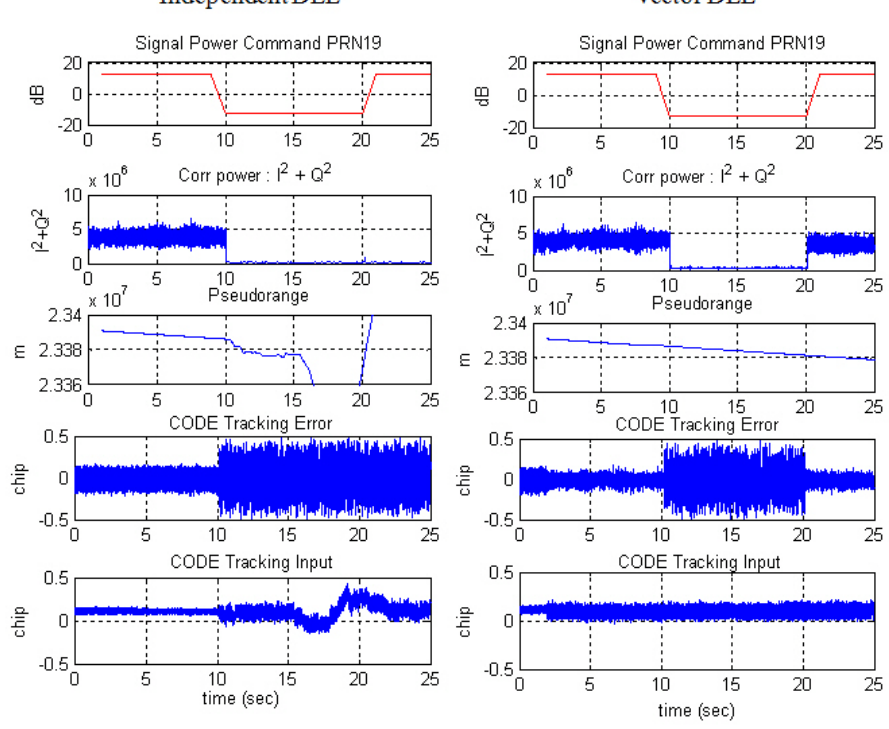
Figure 11. Code tracking result of PRN 19: Independent DLL (left) and Vector DLL (right).